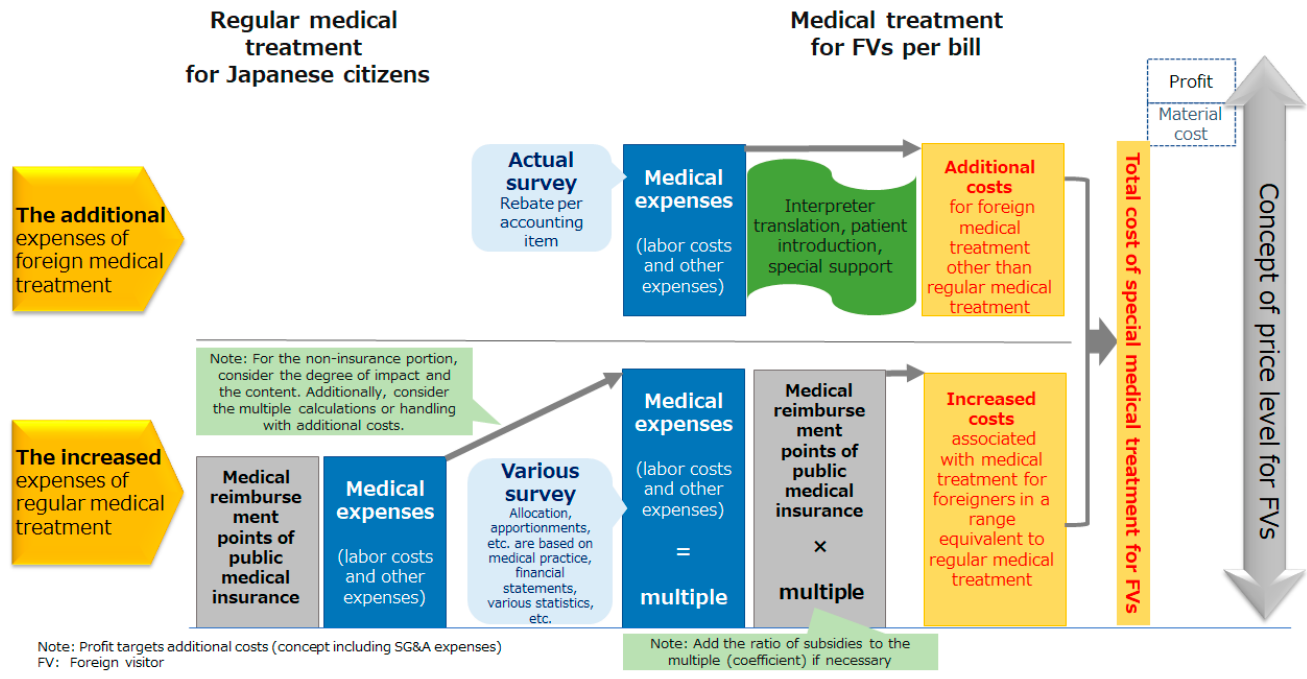
Figure 3. The structure of medical expenses for foreign visitors (FVs); calculation and addition from two perspectives.